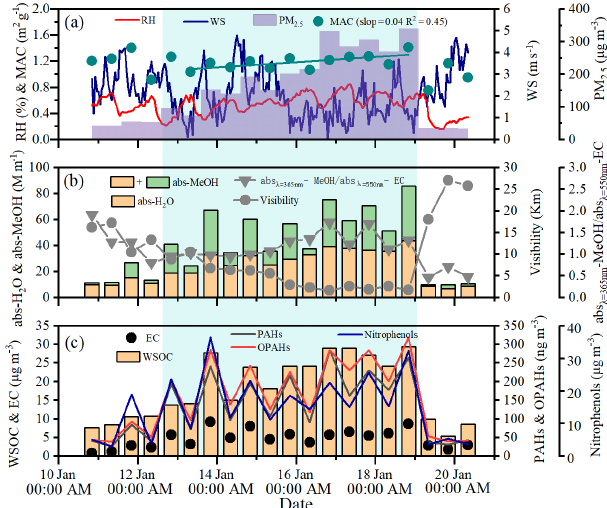
Figure 5. Temporal variations in PM 2 . 5 , meteorological parame- ters, abs λ = 365nm of W(M)SOC and organic compounds in the pe- riod of 10–20 January. The cyan shadow indicates a haze period from 12 to 19 January 2017 with a daily PM 2 . 5 >75µgm − 3 .